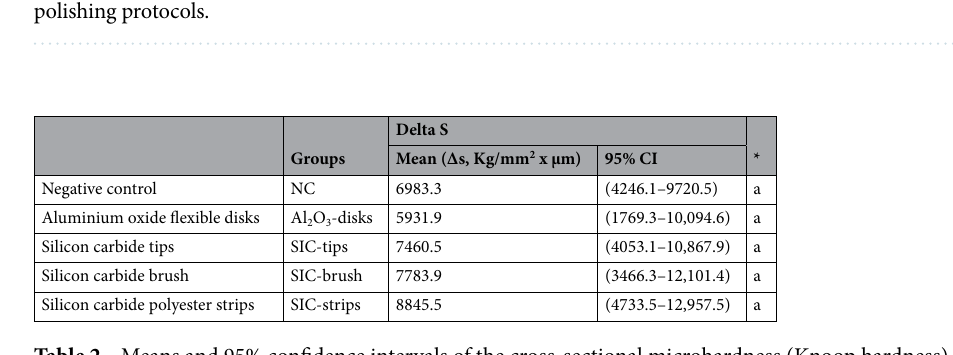
Table 2. Means and 95% confidence intervals of the cross-sectional microhardness (Knoop hardness) measurements. *ANOVA statistical analysis showed no significantly difference between the groups (p =